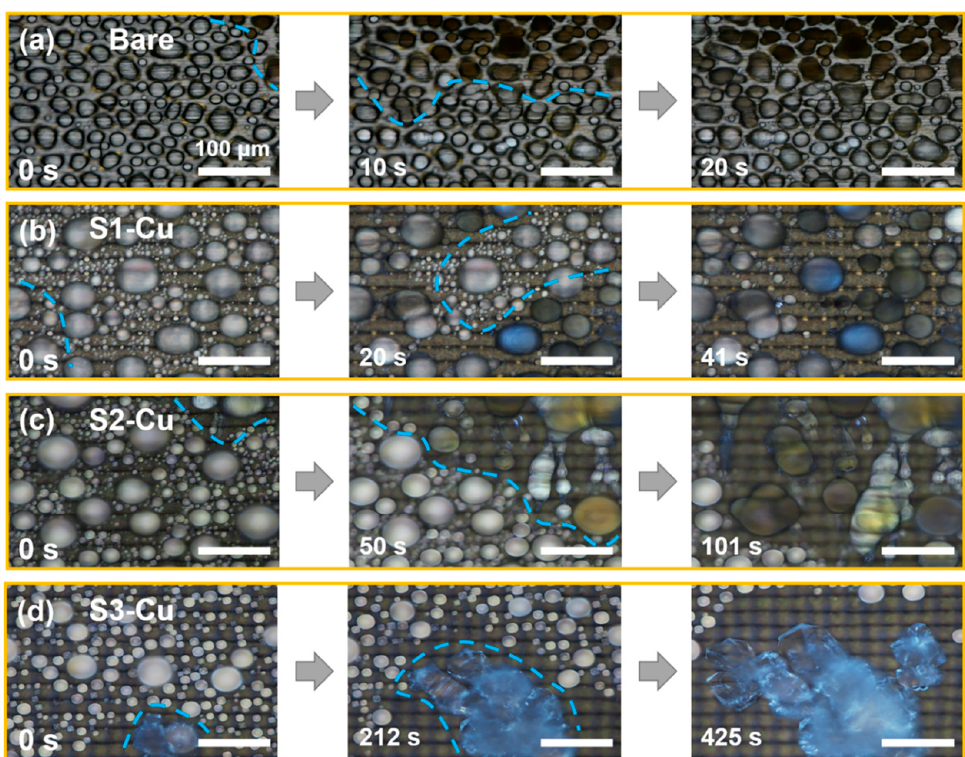
Figure 5. Frost propagation on the prepared surfaces. ( a ) Bare Cu with a frost propagation speed of 22.47 μ m/s. ( b ) S1-Cu with frost propagation speed of 10.96 μ m/s. ( c ) S2-Cu with a frost propagation speed of 4.45 μ m/s. ( d ) S3-Cu with frost propagation speed of 0.47 μ m/s; notably, dry zone formation dominates the frosting process of S3-Cu. The ambient relative humidity and temperature are 26.4 ± 5% and (20.7 ± 2.5) °C, respectively. The cryostage is maintained at ( − 10 ± 1.5) °C ( SSD = 2.25; the frosting propagation processes are recorded using a digital camera at 1 fps (Nikon DS-Ri1).